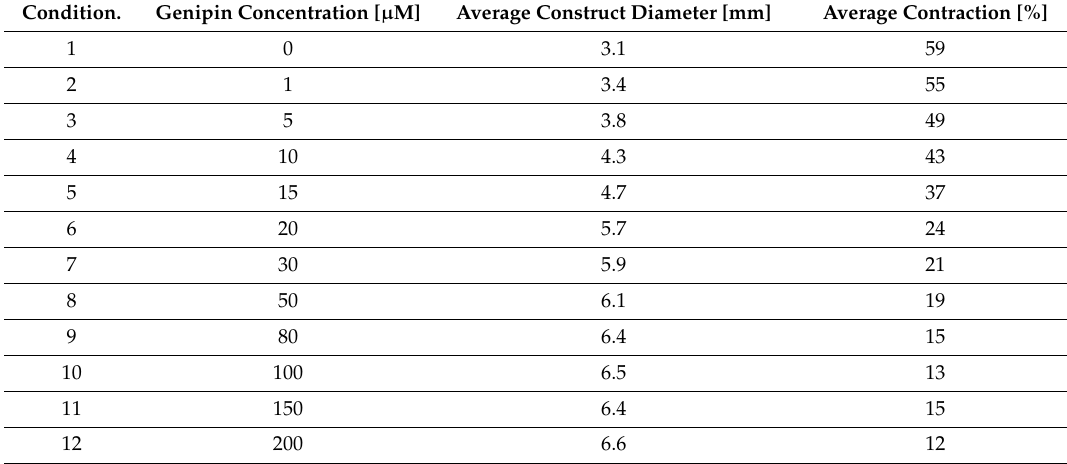
Table 1. The e ff ects of genipin addition on the collagen contraction ( n = 4). Condition. Table 1. The effects of genipin addition on the collagen contraction ( n = 4). Condition.